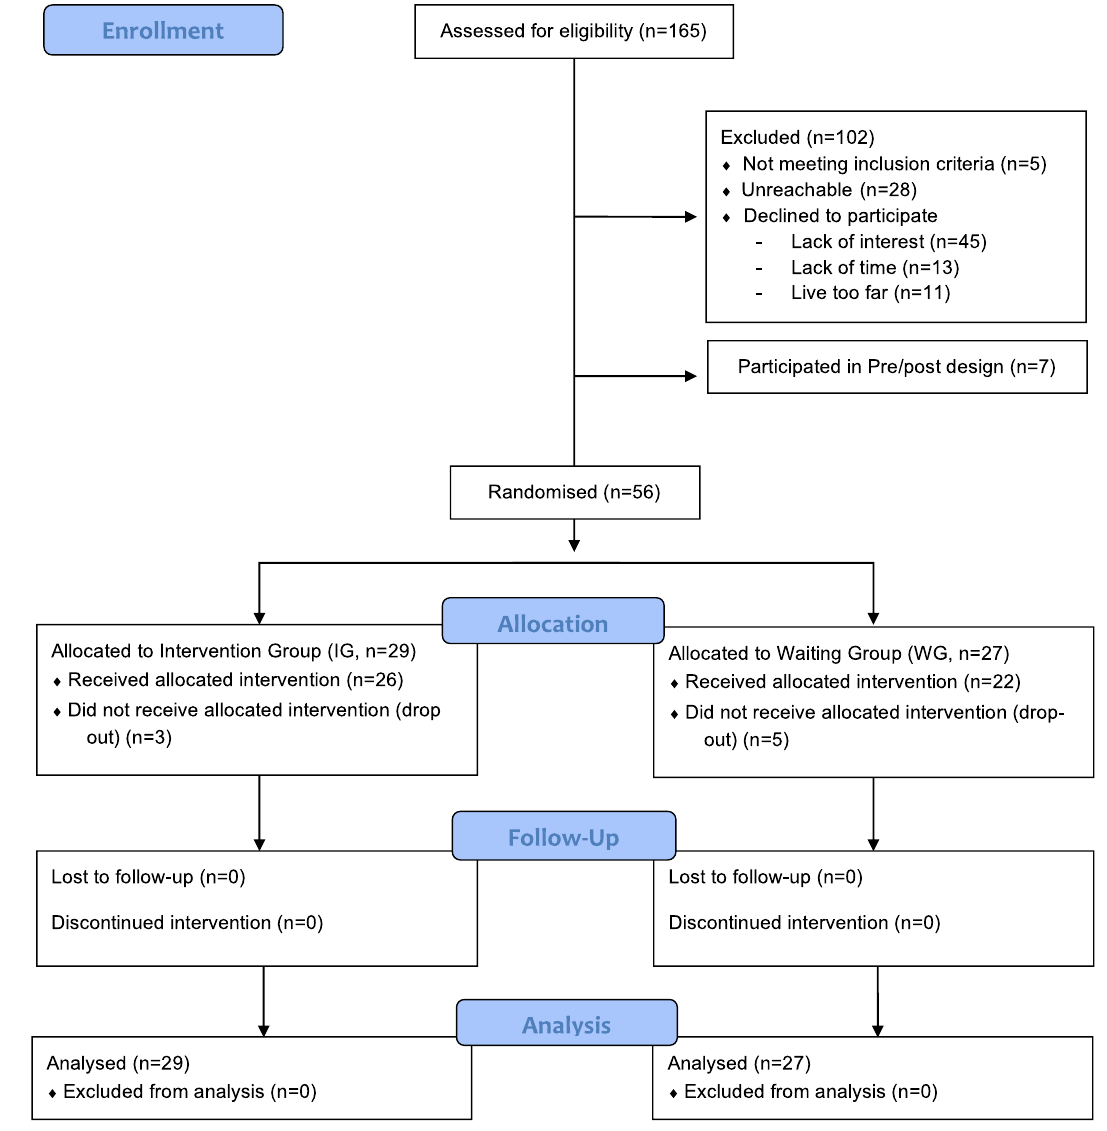
Figure 3. CONSORT flow diagram of the present cross-over RCT